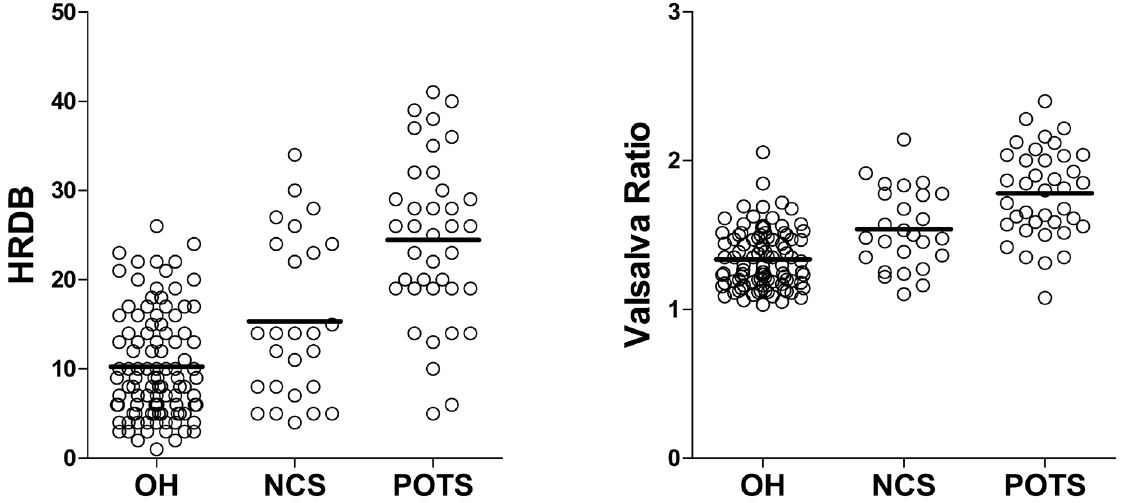
Figure 3. Results of heart rate response to deep breathing and Valsalva ratio. Orthostatic hypotension (OH) patients showed the smallest values in both heart rate response to deep breathing (HRDB; 10.3 6 6.0 beats/min) and Valsalva ratio (1.34 6 0.20) and postural orthostatic tachycardia syndrome (POTS) patients showed the largest values in both HRDB (24.5 6 9.2 beats/min) and Valsalva ratio (1.78 6 0.30). Neurocardiogenic syncope (NCS) patients showed intermediate levels of HRDB (15.4 6 9.1 beats/min) and Valsalva ratio (1.54 6 0.20) compared with OH and POTS patients.